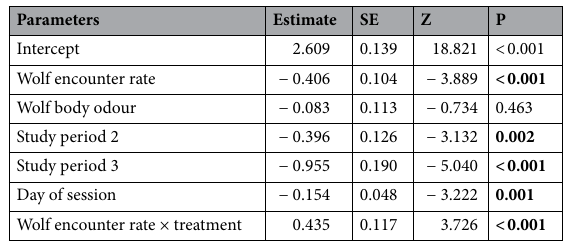
Table 1. Parameter estimates for the generalized linear mixed model with Poisson distribution describing raccoon dog giving up densities. Significant values are in